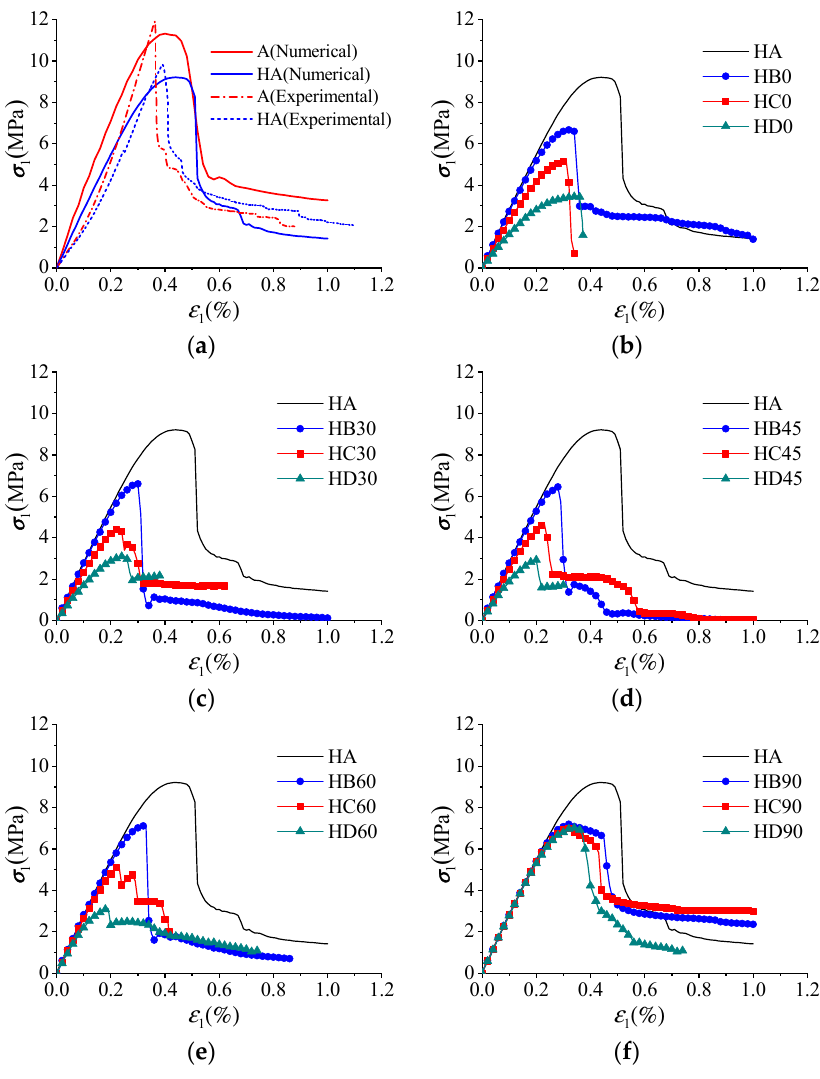
Figure 16. Axial stress–strain curves of all specimens by numerical simulation. ( a ) A and HA; ( b ) β = 0 ◦ ; ( c ) β = 30 ◦ ; ( d ) β = 45 ◦ ; ( e ) β = 60 ◦ ; ( f ) β = 90 ◦ .